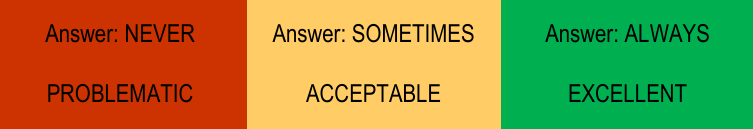
Figure 7. Example of the interpretation of a safety indicator result.